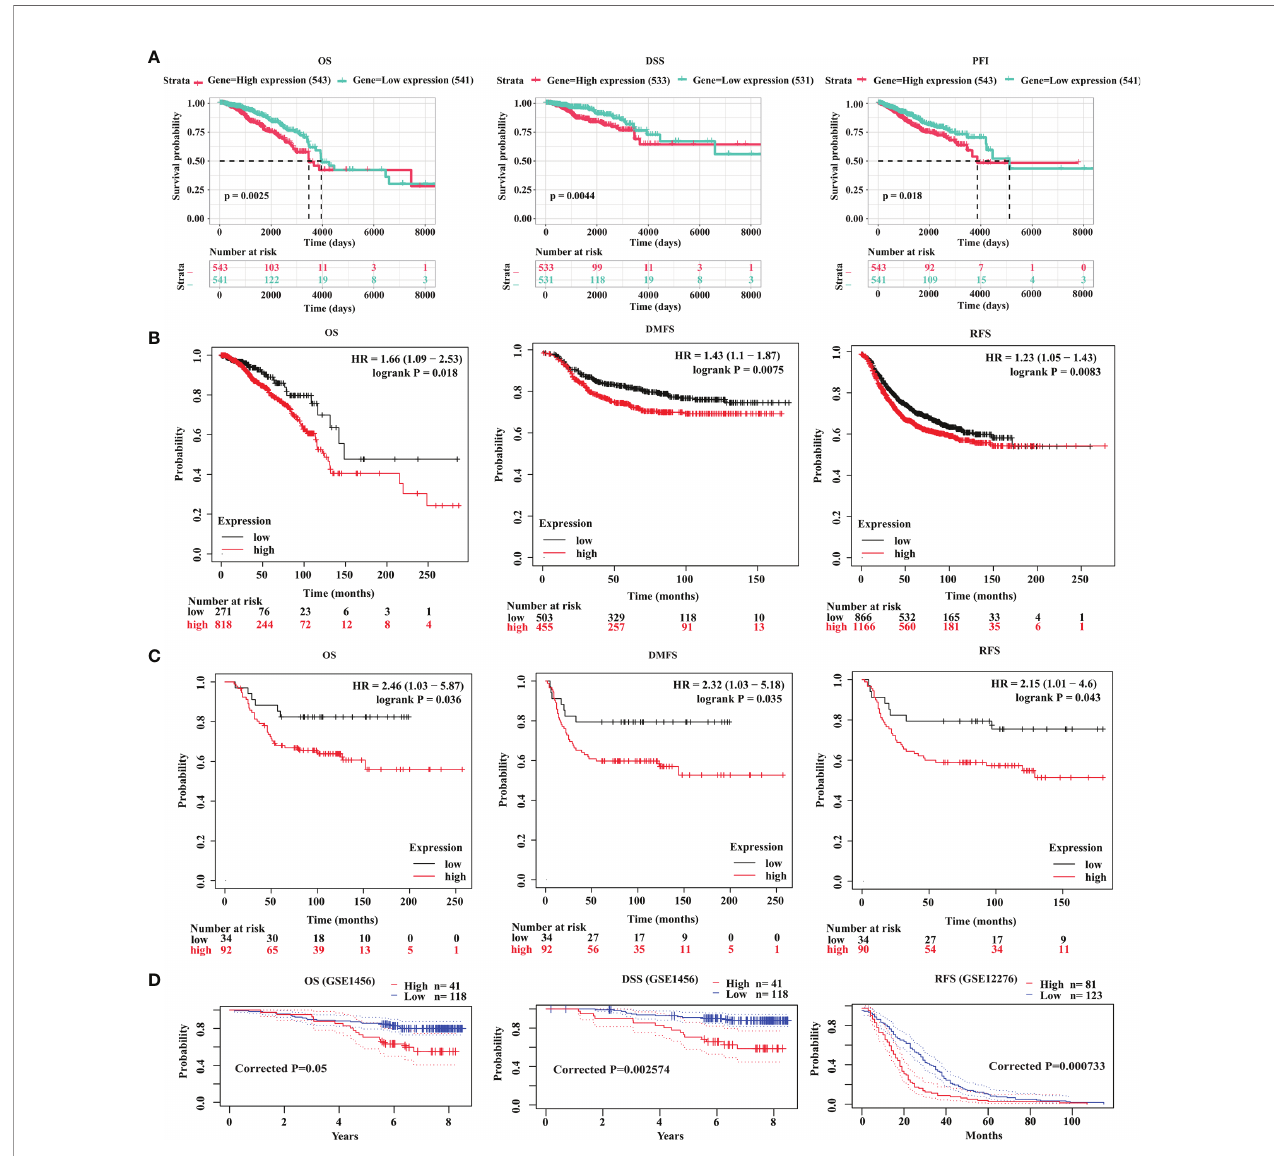
FIGURE 2 | GOLT1B is a potential prognostic factor for breast cancer. (A) The correlation between GOLT1B expression and OS, DSS, PFI of breast cancer patients using the datasets downloaded from TCGA database. The correlation between GOLT1B (B) mRNA expression and (C) protein expression with OS, DMFS, RFS of breast cancer patients as analyzed using the Kaplan-Meier plotter database. (D) The correlation between GOLT1B expression and OS, DSS, RFS of breast cancer patients using the datasets from prognoScan and